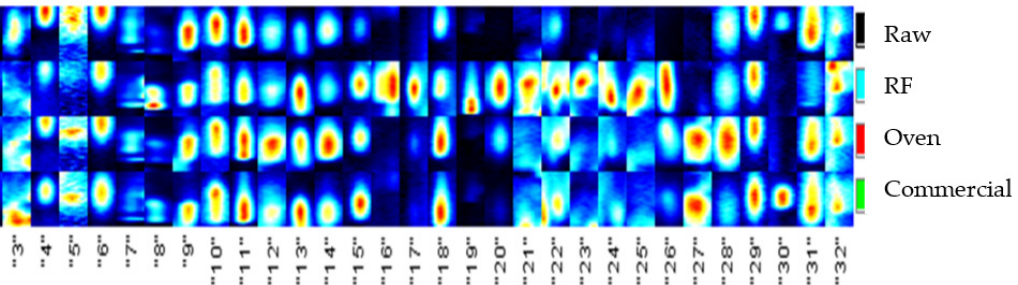
Figure 8. The characteristic aroma fingerprint of raw, RF-roasted, oven-roasted, and commercial almonds.